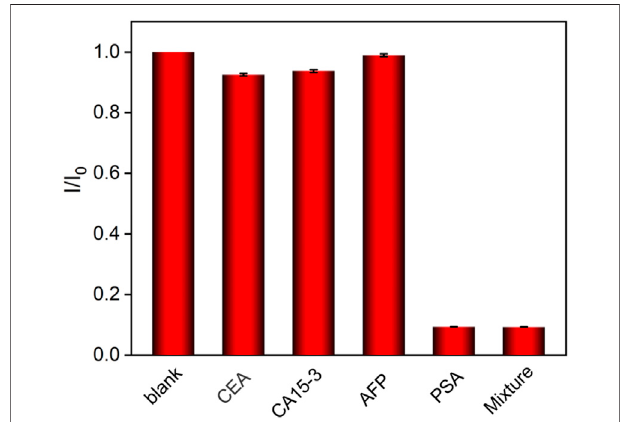
FIGURE 6 | Relative ratio of ECL intensity before (I 0 ) and after (I 0 ) incubation with buffer (blank), CEA (500 ng ml − 1 ), CA15-3 (500 ng ml − 1 ), AFP (500 ng ml − 1 ), PSA (0.1 ng ml − 1 ), or protein mixture (0.1 ng ml − 1 PSA + 500 ng ml − 1 other